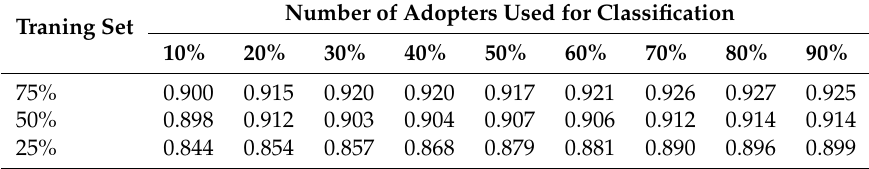
Table 4. Accuracy of classification results with the use of Activity Factors for 25%, 50%, 75% training set and 10%, 20%, ..., 90% of adopters